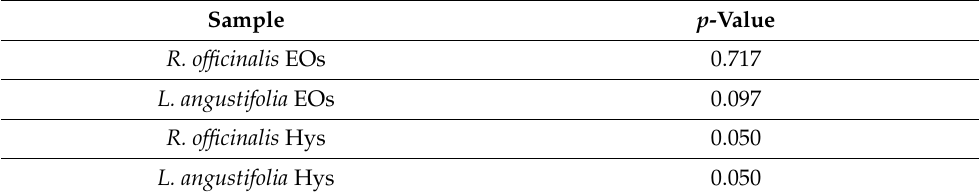
Table 4. Friedman test p -values for testing homogeneity across time.